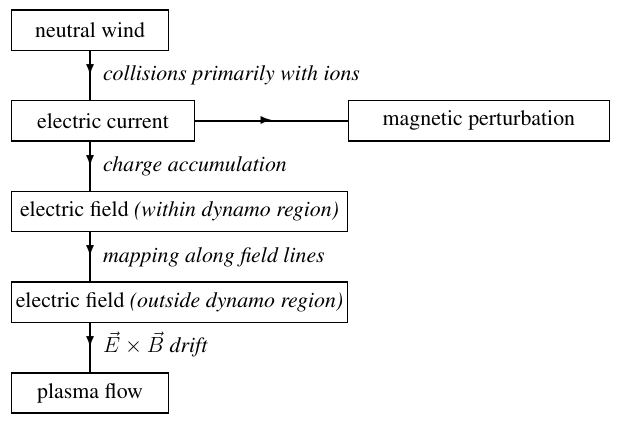
Fig. 4. Schematic diagram of how a neutral-wind dynamo devel- ops, as understood on the basis of the complete physical